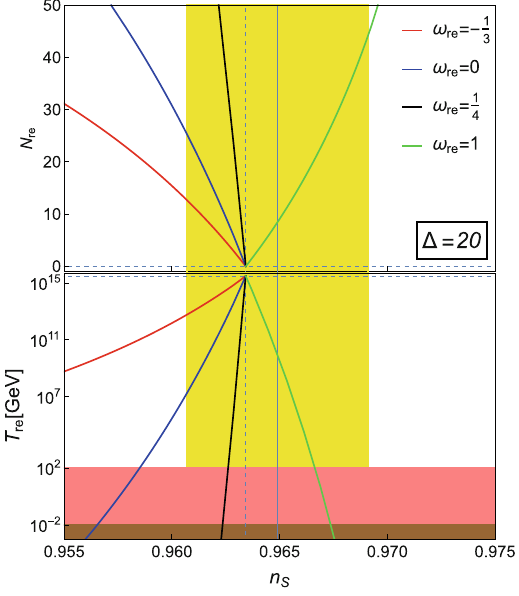
Fig. 3 The n S − T re (bottom) and n S − N re (top) plots for nat- ural inflation with potential given in Eq. (22). The yellow shaded region indicates the current 1 σ range of n S = 0 . 9649 ± 0 . 0042 (68% , TT , T E , EE + lo w E + lensing ) from Planck data [10,11].